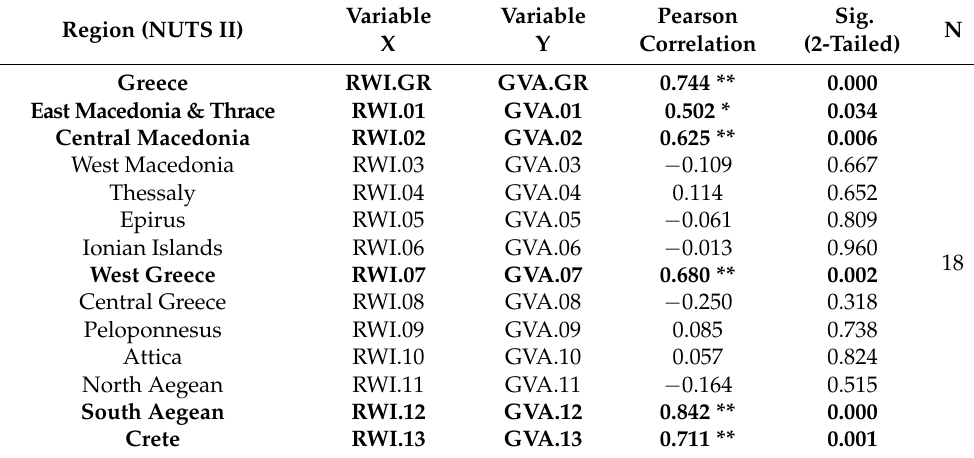
Table 3. Pairwise correlations between diachronic variables (2000–2017) of the Relative Workers Income and Gross Value Added (both for the agricultural sector), configured at the national level and for the 13 Greek regions. Variable Variable Pearson Sig. N Region (NUTS II) X Y Correlation (2-Tailed) Greece RWI.GR GVA.GR 0.744 ** 0.000 East Macedonia & Thrace RWI.01 GVA.01 0.502 * 0.034 Central Macedonia RWI.02 GVA.02 0.625 ** 0.006 West Macedonia RWI.03 GVA.03 − 0.109 0.667 Thessaly RWI.04 GVA.04 0.114 0.652 Epirus RWI.05 − 0.061 0.809 Ionian Islands RWI.06 GVA.06 − 0.013 0.960 18 RWI.07 0.002 0.318 RWI.10 0.057 0.824 North Aegean RWI.11 GVA.11 − 0.164 0.515 South Aegean RWI.12 GVA.12 0.842 ** 0.000 Crete RWI.13 GVA.13 0.711 **